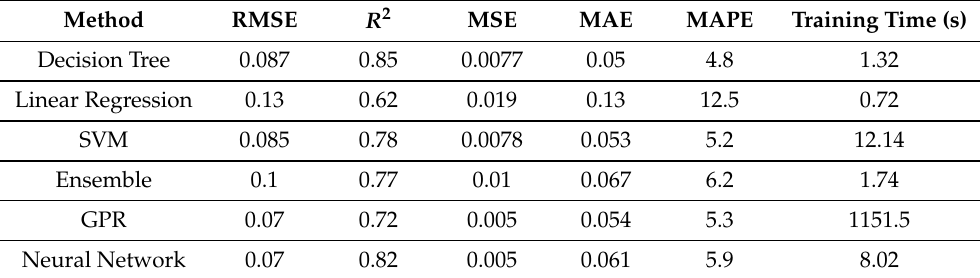
Figure 14. Results with Artificial Neural Network. ( a ) Actual versus predicted values of Artificial Neural Network. ( b ) Linearity analysis of Artificial Neural Network. Table 2. Comparative analysis of forecasting